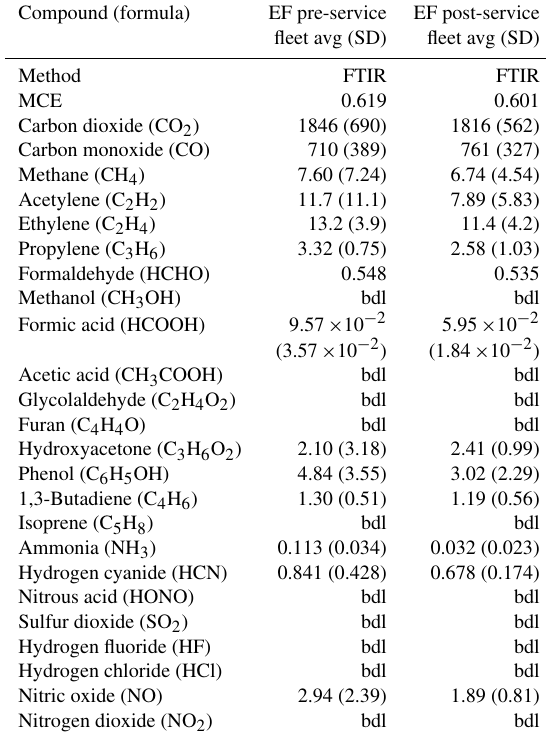
Table 1. Fleet average emission factors (gkg − 1 ) and standard devi- ation for two-wheeled vehicle